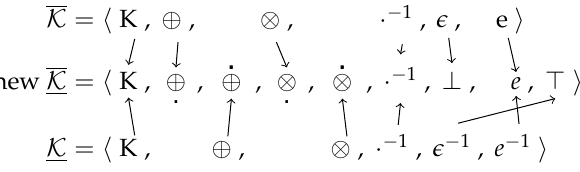
Figure A1. Construction of the aggregated structure of a completed naturally ordered semifield with its inverse, e.g max-min-plus. The name refers to the original basis for the construction, e.g., K since they share the natural